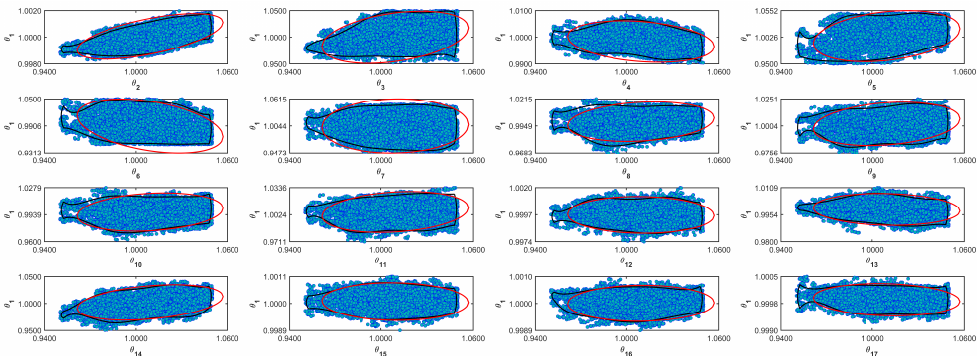
Figure A1. Coverage regions of parameters 01: (—) Gaussian region; (—) Possolo [33] region.